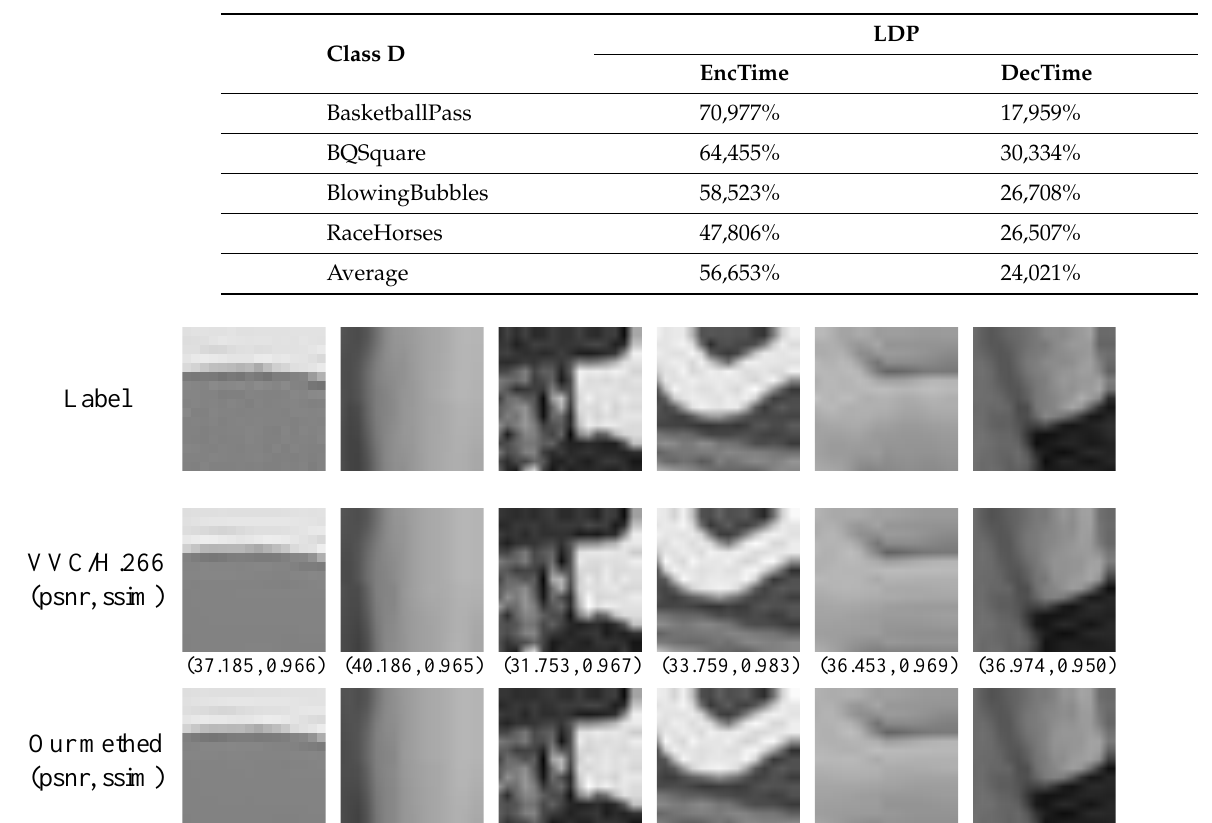
Table 2. Complexity of our method.